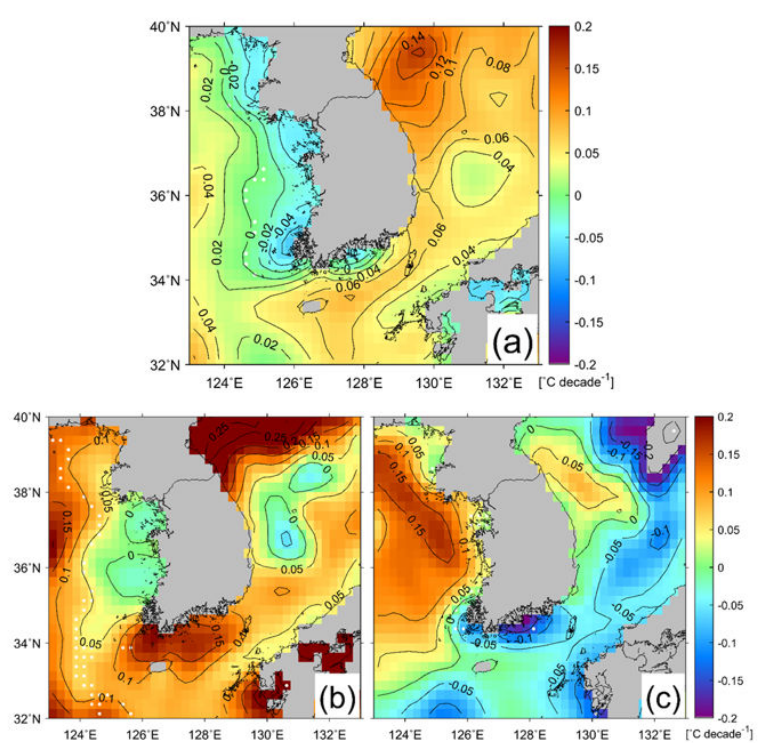
Figure 8. ( a ) SST trend ( ◦ C decade − 1 ) for 1982 to 2018 from the OISST data; SST trends for the periods of ( b ) 1982 to 2000 and ( c ) 2000 to 2018, where a white dot represents a pixel of statistically insignificant trend within the 95% confidence